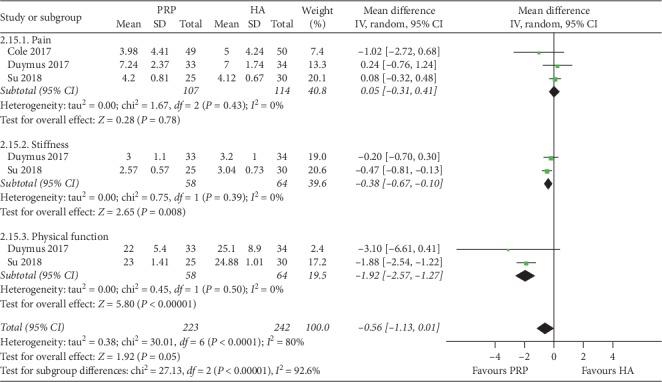
Forest plots showing the effect of PRP on WOMAC scores at 3rd months of follow-up compared with HA in overweight patients with knee OA. WOMAC: Western Ontario and McMaster Universities Osteoarthritis Index.